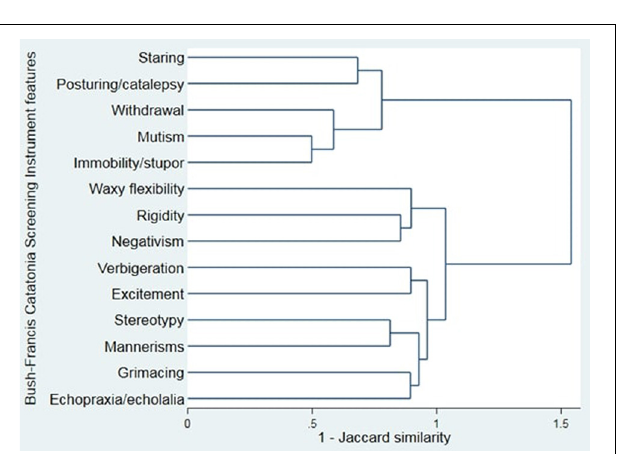
FIGURE 3 | Cluster analysis dendrogram of the Bush-Francis Catatonia Screening Instrument (Ward’s